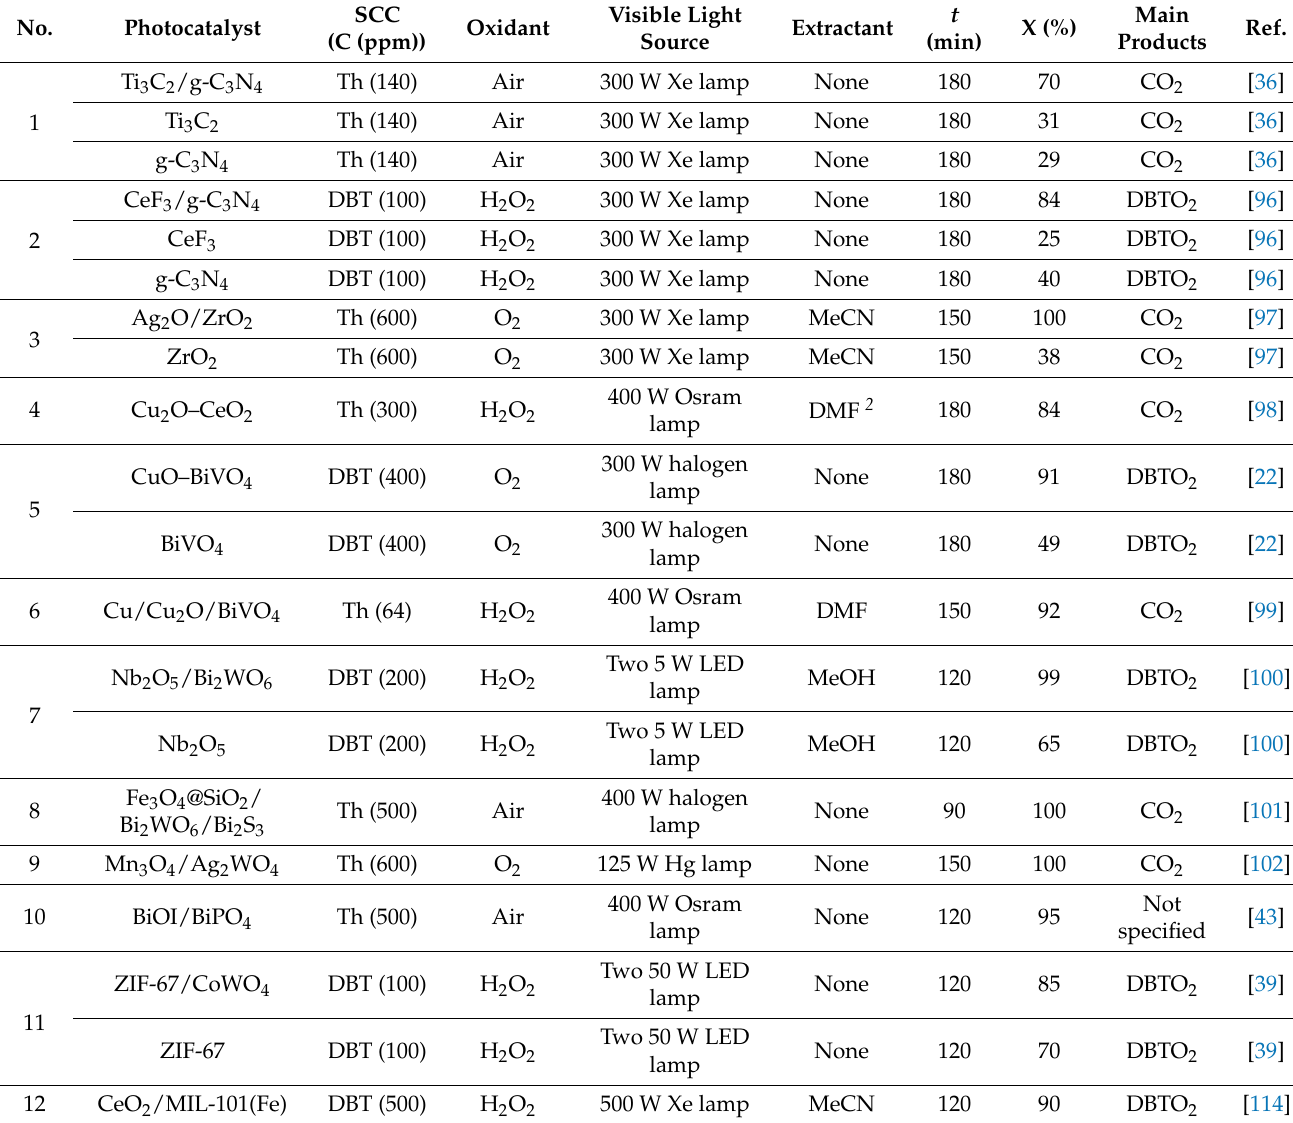
Table 3. Activity of various type-II heterojunctions in PODS 1